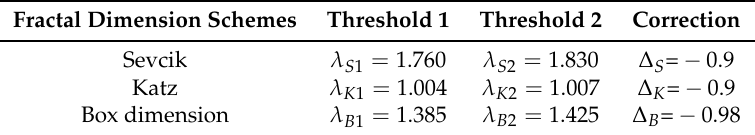
Table 1. The values of the threshold and the correction in different schemes.